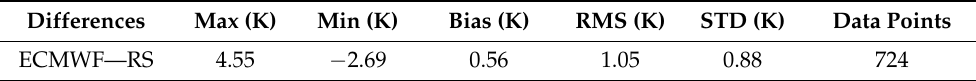
Table 4. Statistical summary for the comparison between RS − T m and T m from VMF1/ECMWF (vmf1 minus RS) in terms of max, min, bias, STD and